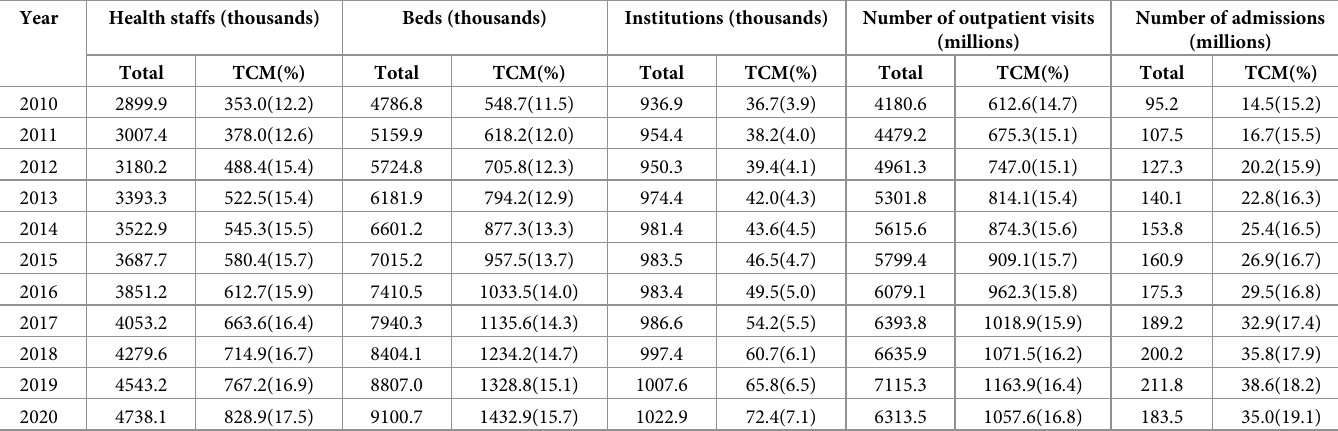
Table 1. Trends of TCM health resources and services from 2010–2020.